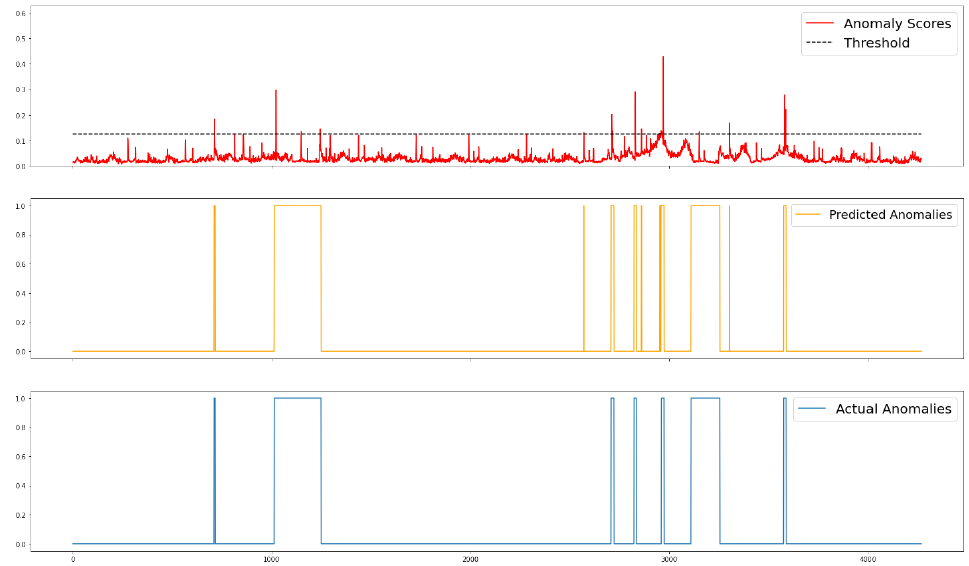
Figure 3. Visualization of entity-level anomaly